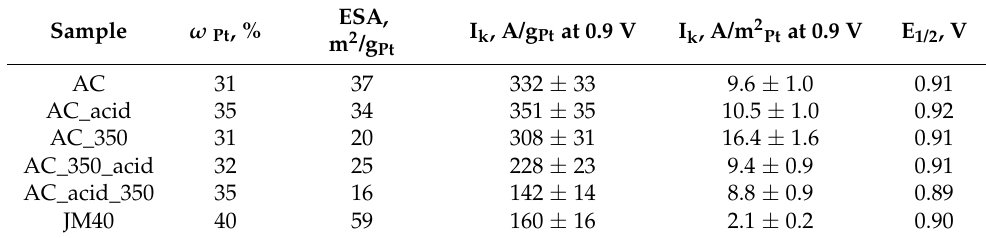
Figure 5. The cyclic voltammograms ( a ) and the linear sweep voltammograms at 1600 rpm ( b ) of the AC (the solid line), AC_acid (the dashed line), and AC_350 (the dash-dotted line) samples; the electrolyte is HClO 4 ; and the potential sweep rate is 20 mV/s. Table 2. The electrochemical characteristics of the studied PtCu/C catalysts.